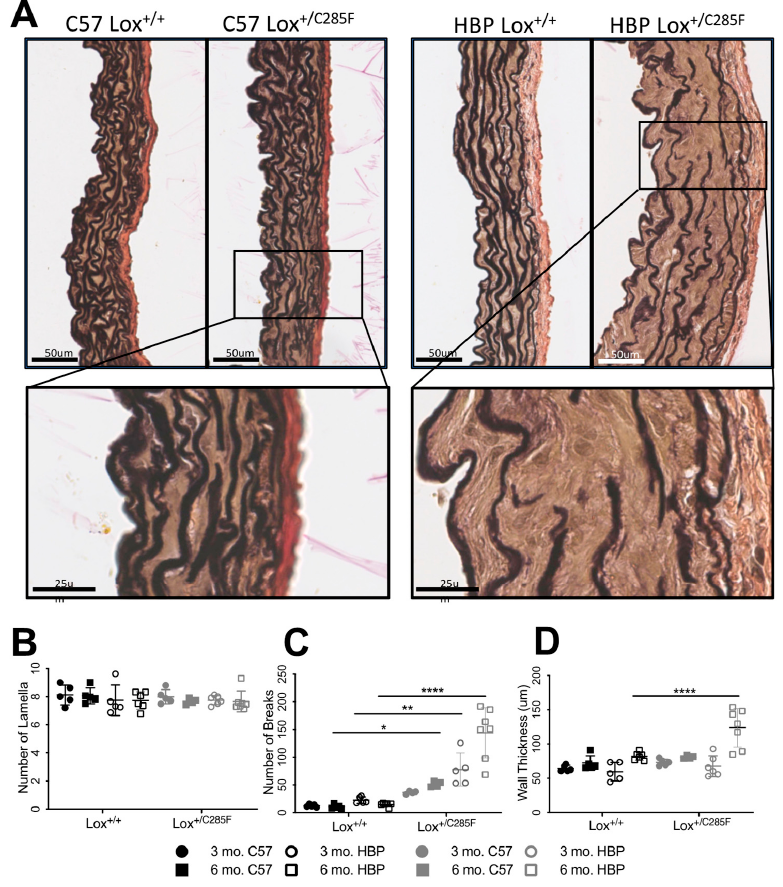
Figure 4. Increased elastic lamellar breaks in Lox +/C285F mice. ( A ), EVG staining of 6-month C57, and HBP Lox +/C285 aortas revealed largely intact but disorganized elastic lamellae. Enlarged insert in ( A ) demonstrates the presence of breaks in Lox +/C285F . ( B – D ), Quantification of the number of lamella ( B ), breaks ( C ), and wall thickness ( D ) in Lox +/+ and Lox +/C285F mice under both C57 and HBP backgrounds showed an increasingly disorganized and thick vascular wall, most obvious in the 6-month HBP Lox +/C285F (Lox effect p < 0.0001, age effect p < 0.05 and HBP effect <0.001, multivariable regression, see Supplemental Table S1. * p < 0.05; ** p < 0.01; **** p <